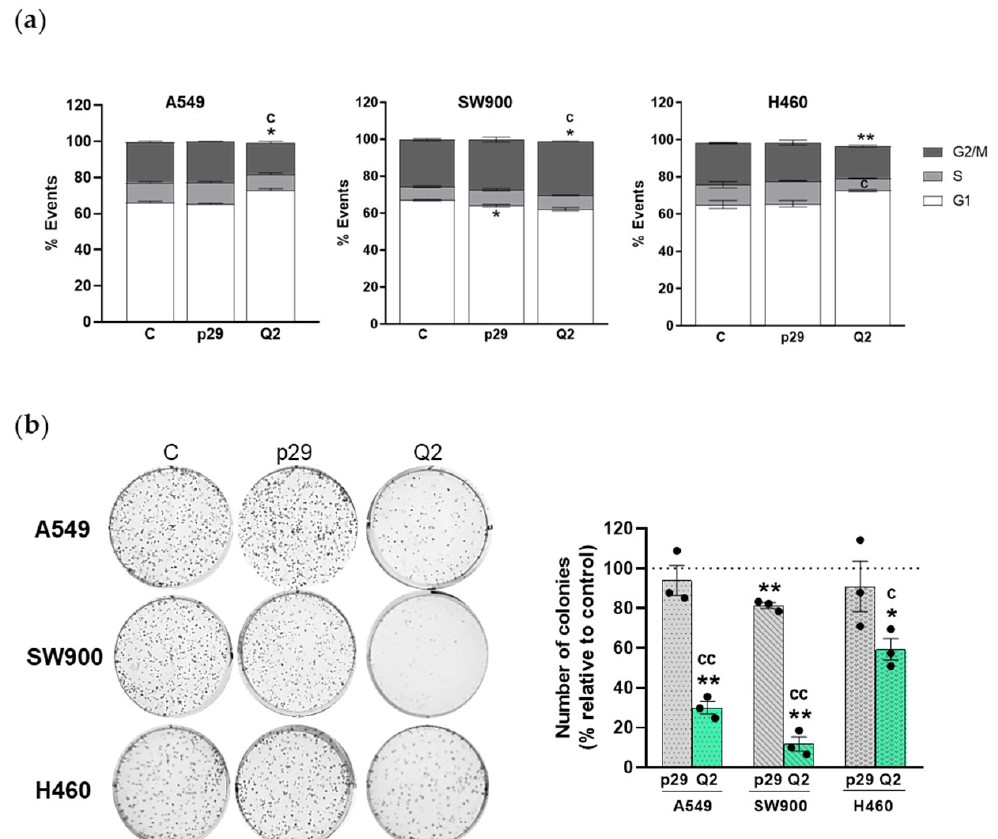
Figure 3. apMNKQ2 arrests cell cycle progression and colony formation in NSCLC cells. ( a ) Cells were transfected with apMNKQ2 at IC50 concentrations. After 24 h, cells were stained with PI and analyzed by flow cytometry. The bars represent the mean percentage of cells gated in each phase, G1 (white), S (grey), and G2/M (dark grey) ± SEM of 3 independent experiments. ( b ) Cells were transfected with aptamers at IC50 and after 24 h reseeded at 10 3 cells/well in 6-well plates. After 7–8 days, colonies were fixed, stained, and counted. (Left) shown are representative images. (Right) The bars represent the mean percentage of the number of colonies obtained ± SEM of 3 independent experiments relative to control (C). * p < 0.05 and ** p < 0.01 relative to control cells; c p < 0.05 and cc p < 0.01 relative to p29 control. Control is shown as C, p29 is the unspecific aptamer used as a negative control, and apMNKQ2 is shown as Q2. Each solid black circle represents one individual value.